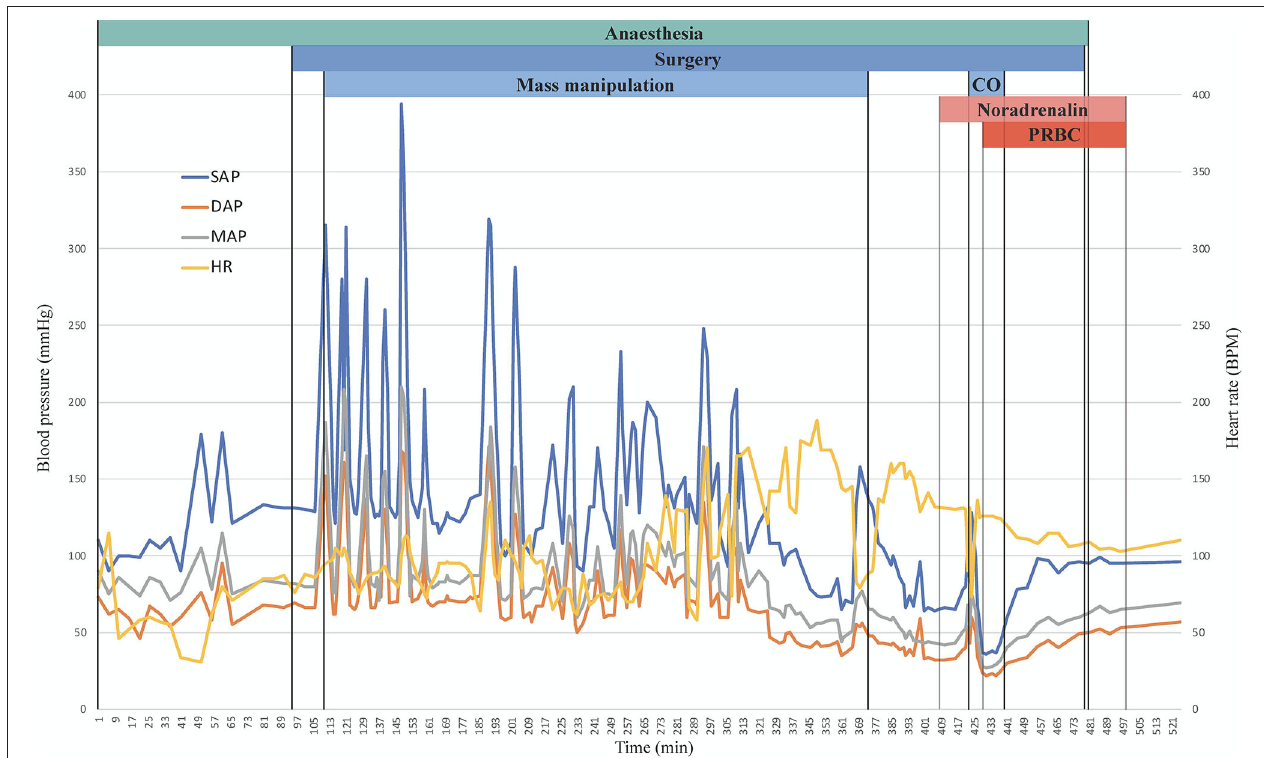
FIGURE 1 | Graphical representation of systolic (blue), diastolic (orange), and mean (grey) arterial pressure and heart rate (yellow) over time expressed in minutes after induction. On the top of the graph, a simplified timeline of the procedure is depicted, the end of the graph corresponds to the extubation. SAP, systolic arterial pressure; DAP, diastolic arterial pressure; MAP, mean arterial pressure; BPM, beats per minute; CO, Caval occlusion; PRBC, packed red blood cells.